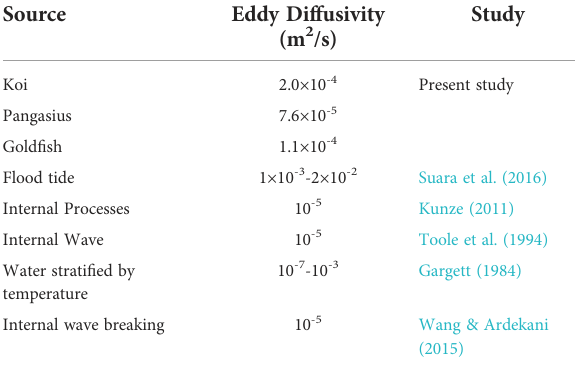
TABLE 6 Comparison of the eddy diffusivities associated with the fi sh schools (at their natural abundances and at a water temperature of 24°C) in the present study and those of various physical